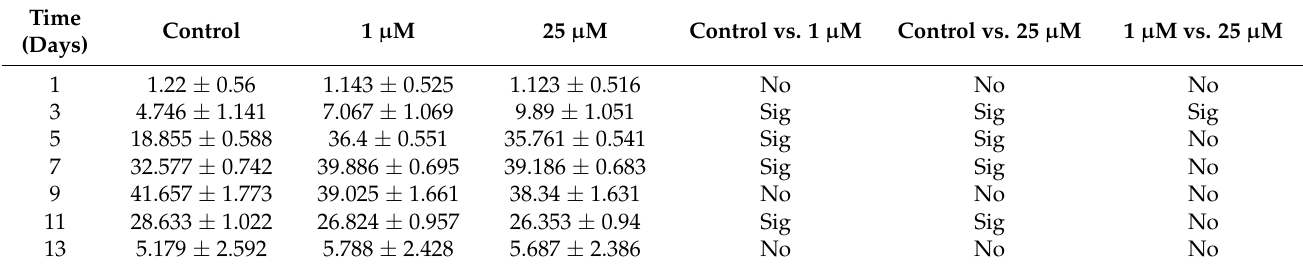
Table 4. Growth curve.